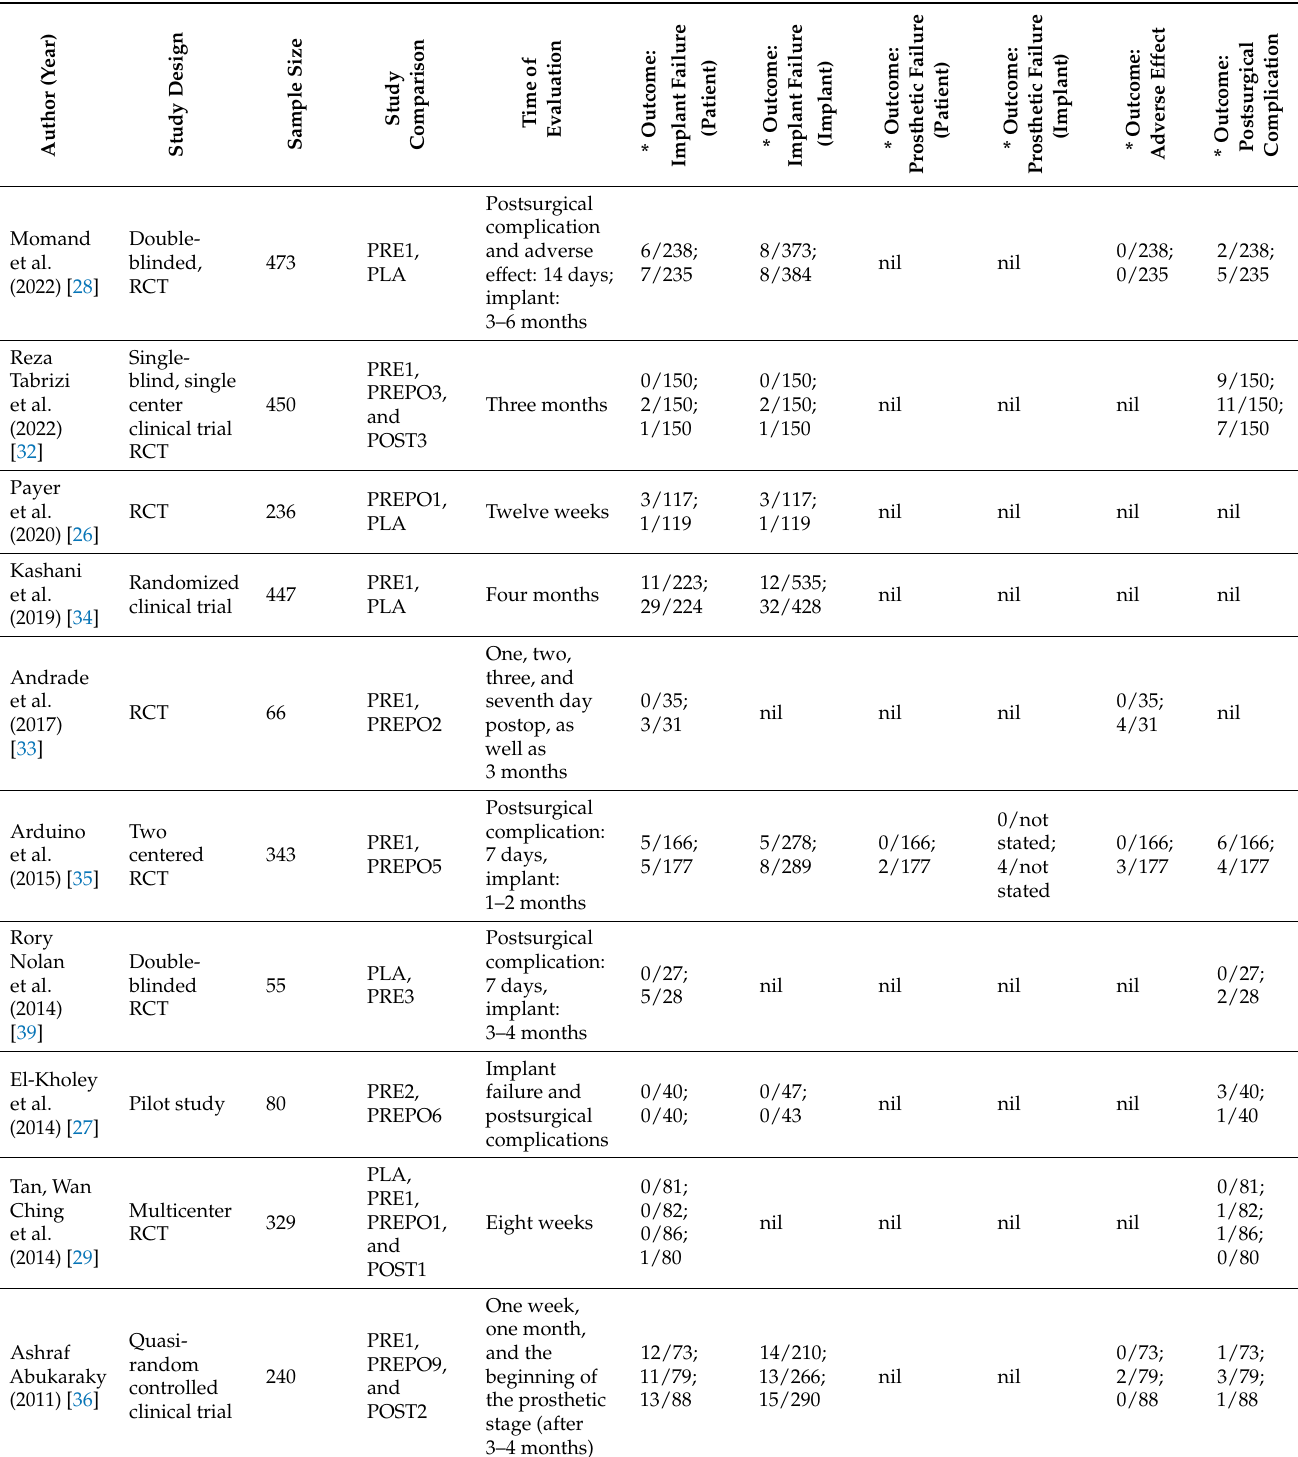
Table 1. Characteristics of included